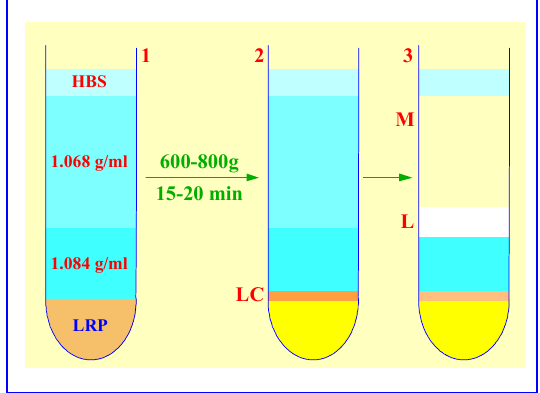
FIGURE 1. Density of human blood cells.